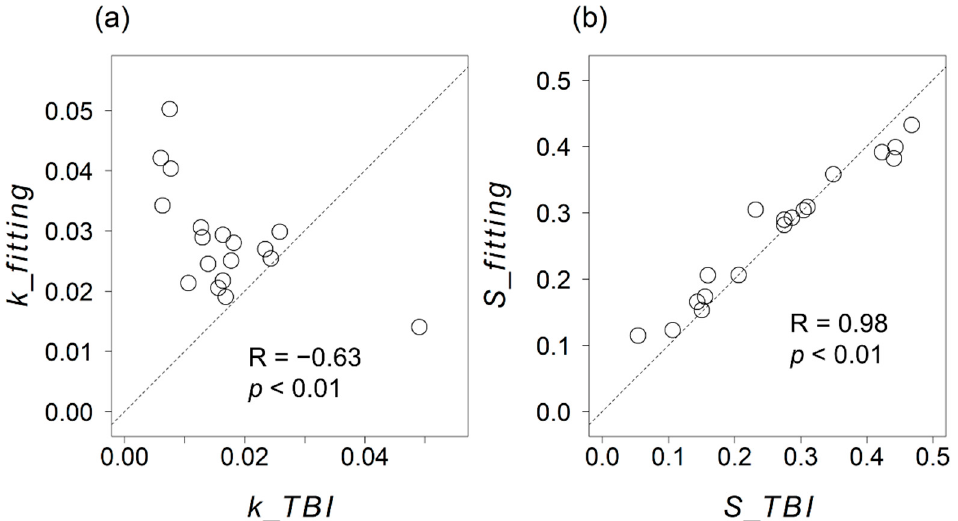
Figure 6. Relationships between ( a ) k_fitting and k_TBI and ( b ) S_fitting and S_TBI . Dashed lines indicate the 1:1 lines.